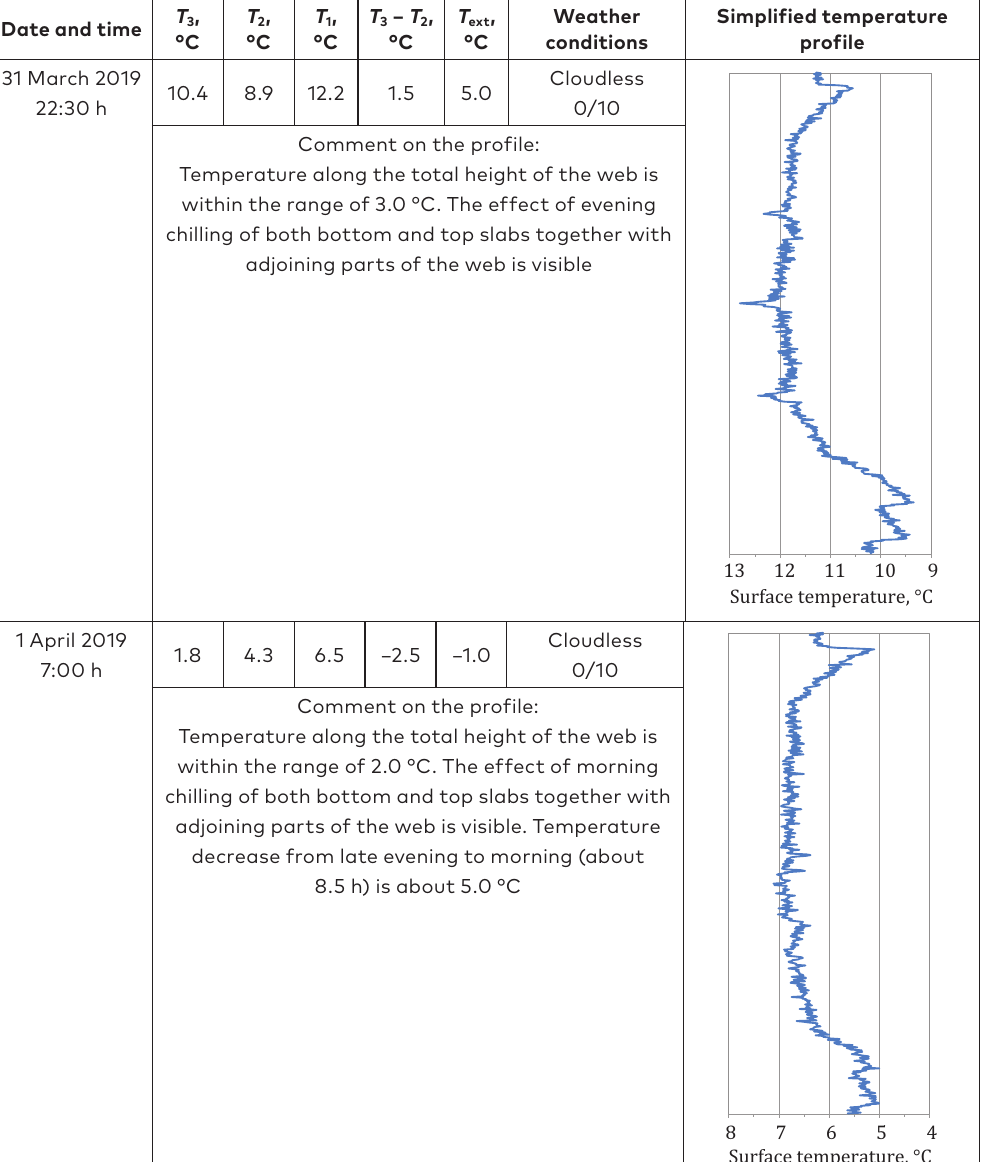
Table 1. Temperatures taken in the main steel box girder of the